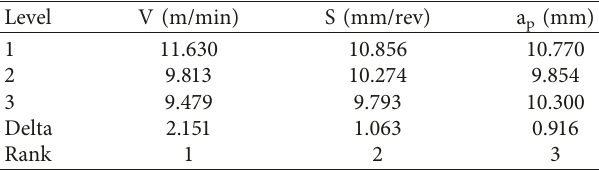
Figure 5: S/N ratio’s main effects for temperature. Table 7: Signal-to-noise ratio for “VB”: response table.